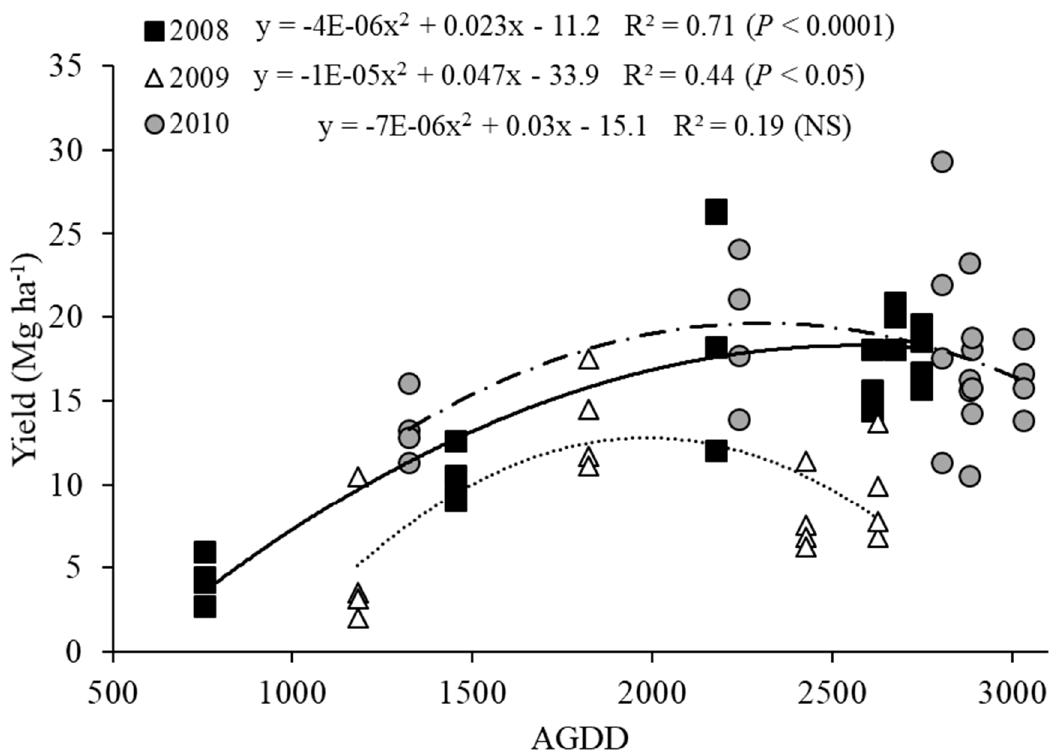
Figure 2. Switchgrass yield as a function of AGDD (accumulated growing degree days) harvests in